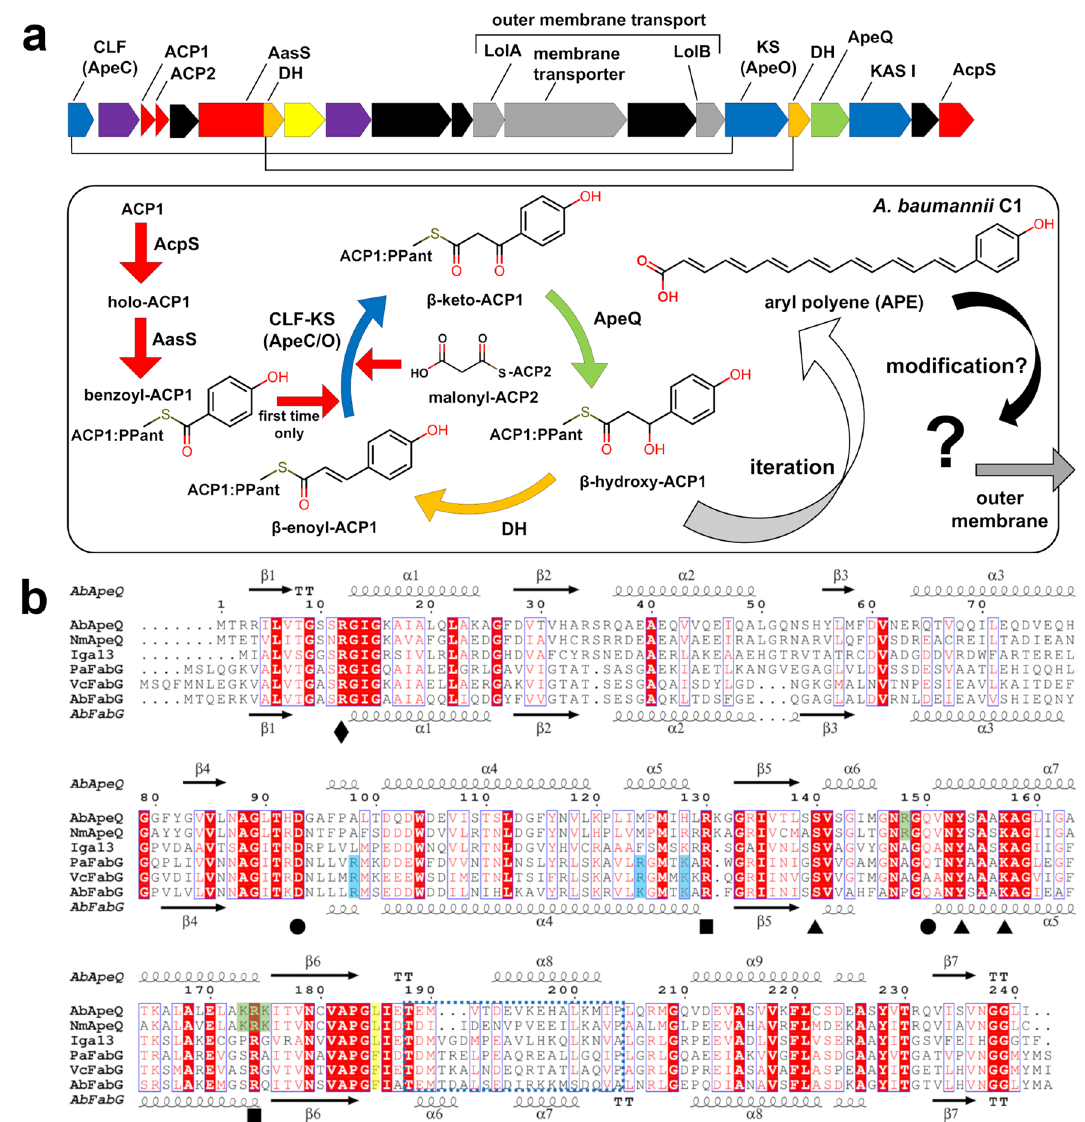
Figure 1. Genomic context of APE biosynthesis genes in A. baumannii and multiple sequence alignment of AbApeQ with its homologs. ( a ) Genomic context of A. baumannii APE biosynthesis genes. Proteins forming heterodimers are linked by lines. Proteins participating in APE elongation are schematically illustrated below with matching colors. DH dehydratase, KS ketosynthase, CLF chain length factor. ( b ) Multiple sequence alignment of AbApeQ and homologs or FabG protein: AbApeQ, A. baumannii ApeQ (NCBI accession number: ACC55845.1); NmApeQ, Neisseria meningitidis ApeQ (NP_274706.1); Iga13, Streptomyces sp. MSC090213JE08 ishigamide biosynthesis ketoreductase (BAX64254.1); PaFabG, P. aeruginosa PAO1 FabG (NP_251657.1); VcFabG, Vibrio cholerae O1 biovar El Tor str. N16961 FabG (AAF95169.1); AbFabG, A. baumannii FabG (ACC56088.1). Catalytic residues are marked by triangles. Two arginine residues that are presumed to interact with ACP and are conserved among ApeQ and FabG homologs are marked by black squares. The Leu185 residue of AbApeQ, which interacts with the 4-hydroxybenzoyl moiety, is highlighted in yellow. The Arg12 residue interacting with NADPH is marked using a diamond. The lid helices and ACP1-binding residues consisting of residues lining the ketoacyl group-binding site are indicated by a dashed blue square. Residues that appear to be important for ACP binding are highlighted in green (AbApeQ) or blue shading (AbFabG). Secondary structures of AbApeQ and AbFabG are depicted at the top and bottom of the alignment,